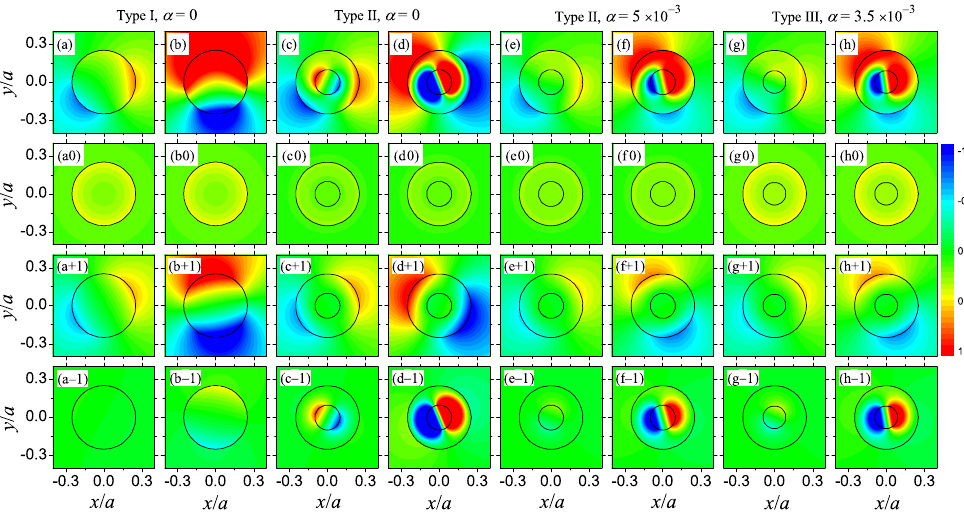
Figure 7. The scattered electric field from the ferrite rod positioned at the origin of MM slab of type I ( a , b ), type II ( c , d ) with damping factor α = 0 and α = 5 × 10 − 3 ( e , f ), and type III with damping factor α = 3.5 × 10 − 3 ( g , h ). The total scattered fields (the 1st row) and the scattered partial fields associated with the angular momentum channel of 0-th order (the 2nd row), +1st order (the 3rd row), and − 1st order (the 4th row) are plotted for the incident angle θ inc = ± 55 ◦ . The permittivities are 1 and 15, the core radii are 0.88 mm and 0.8 mm for the MMs of type II and III, and the other parameters are the same as those in Figure